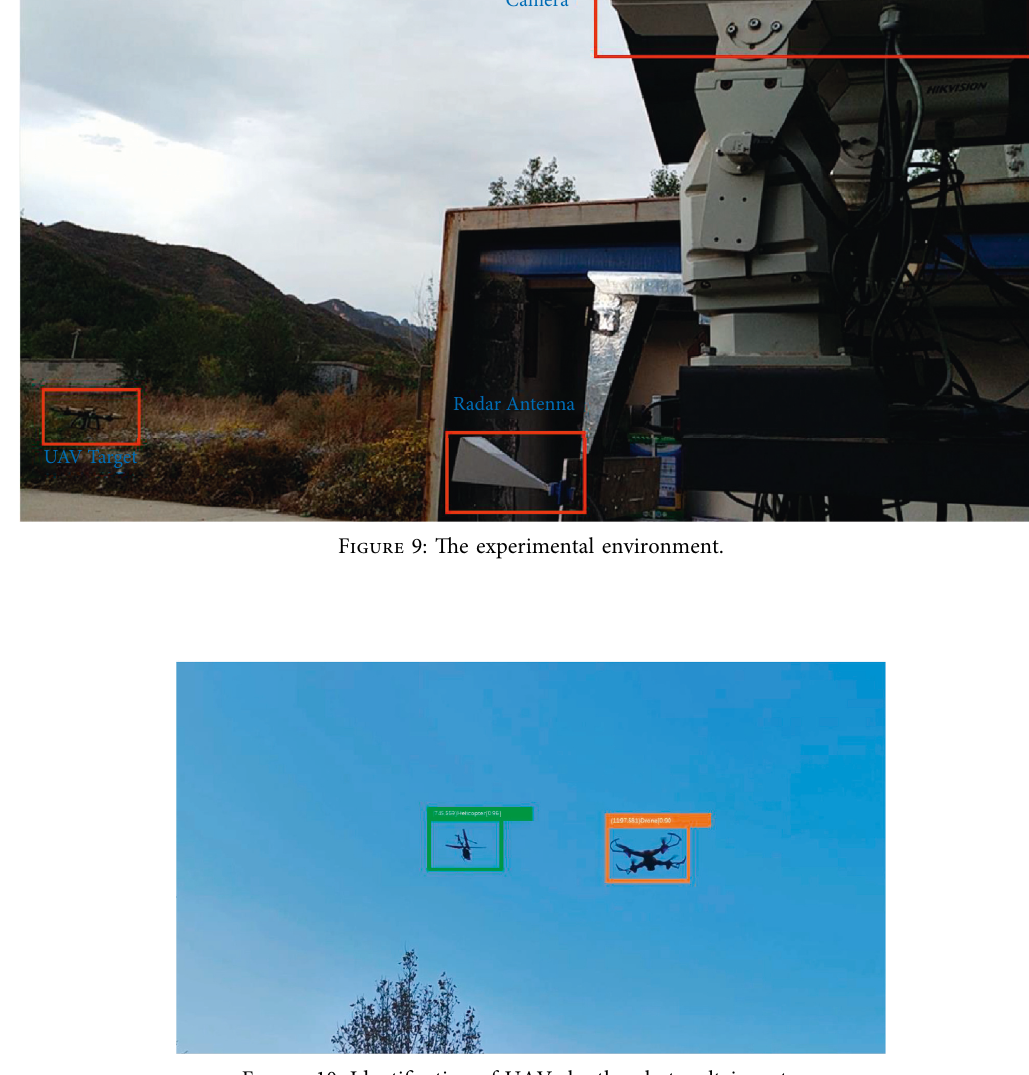
Figure 10: Identification of UAVs by the photovoltaic